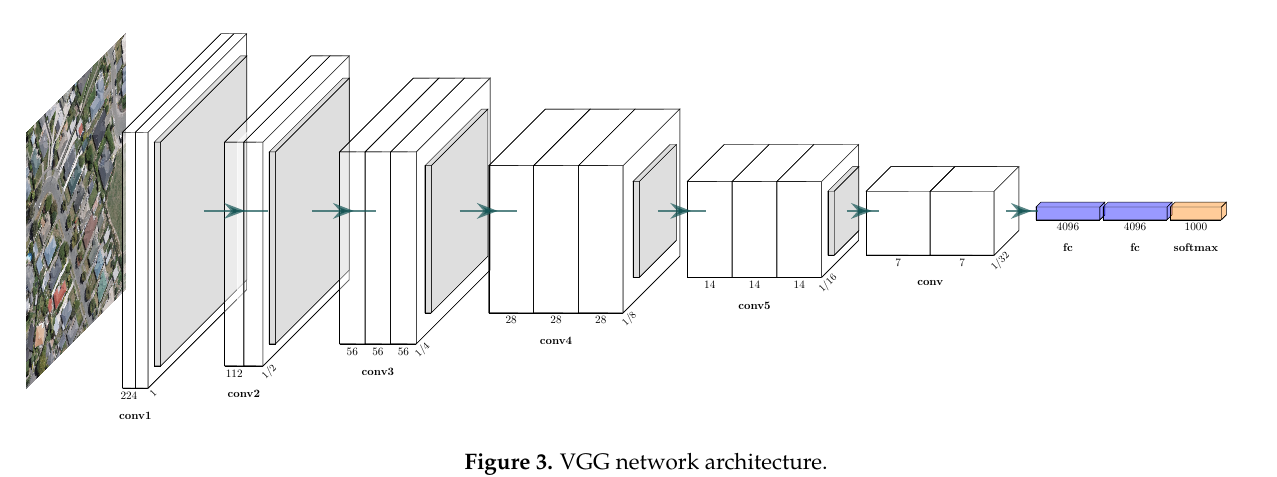
Figure 3. VGG network architecture.